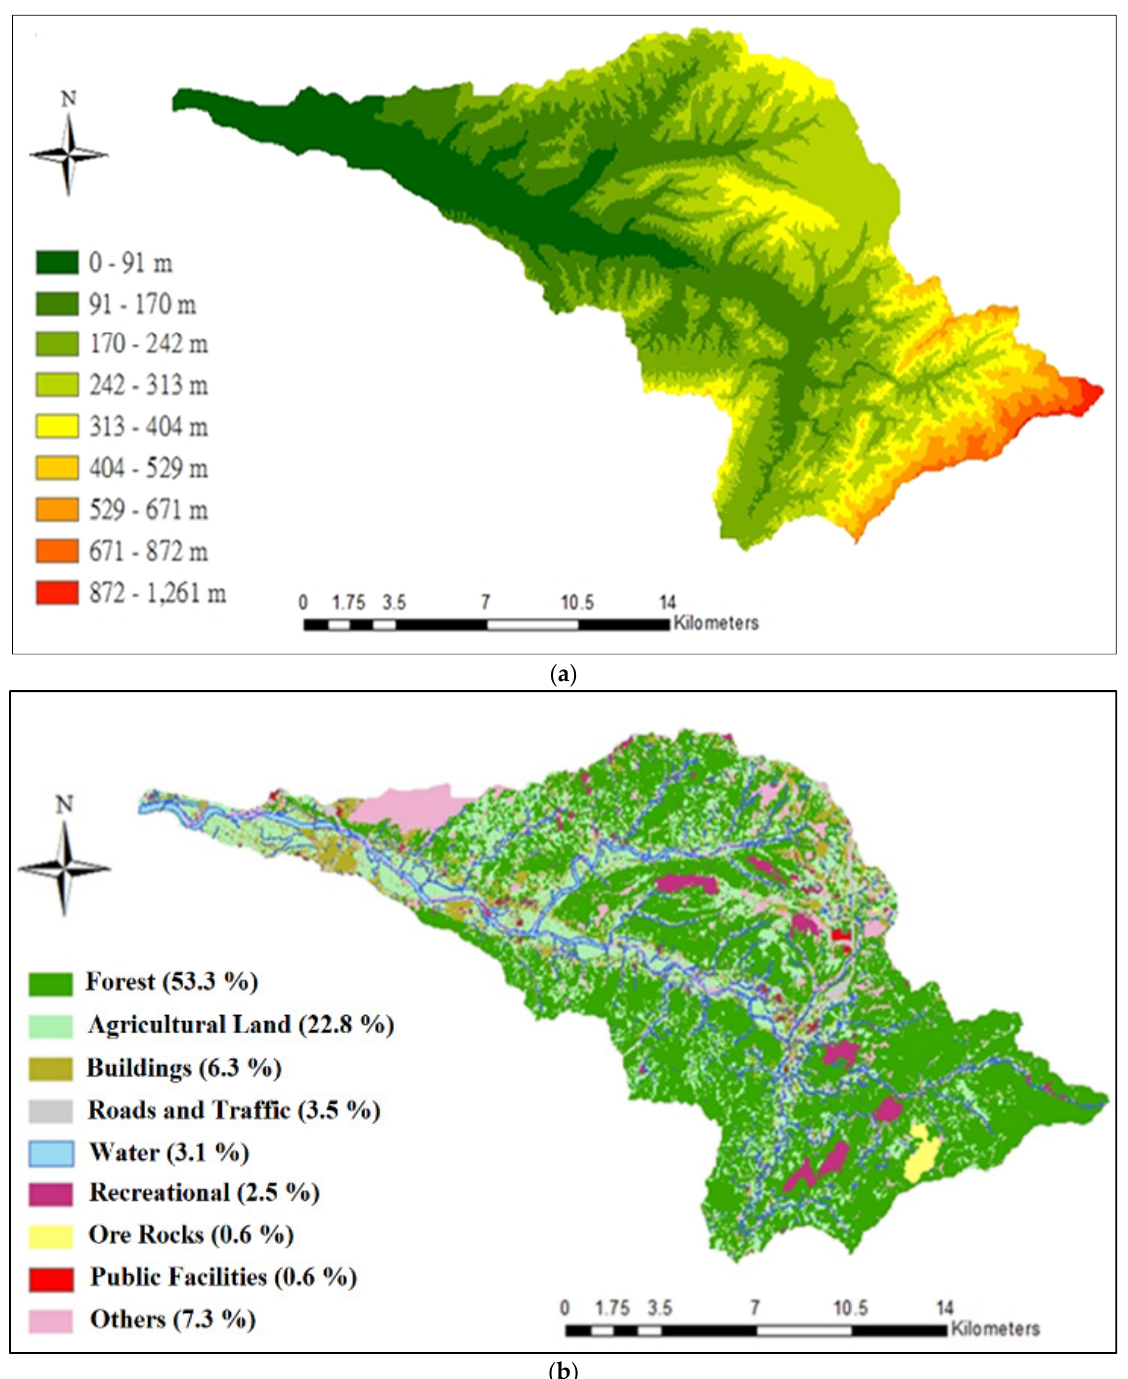
Figure 3. ( a ) Digital Elevation Model of the year 2016, ( b ) Landuse classification map of Fèngsh ā n River Basin.